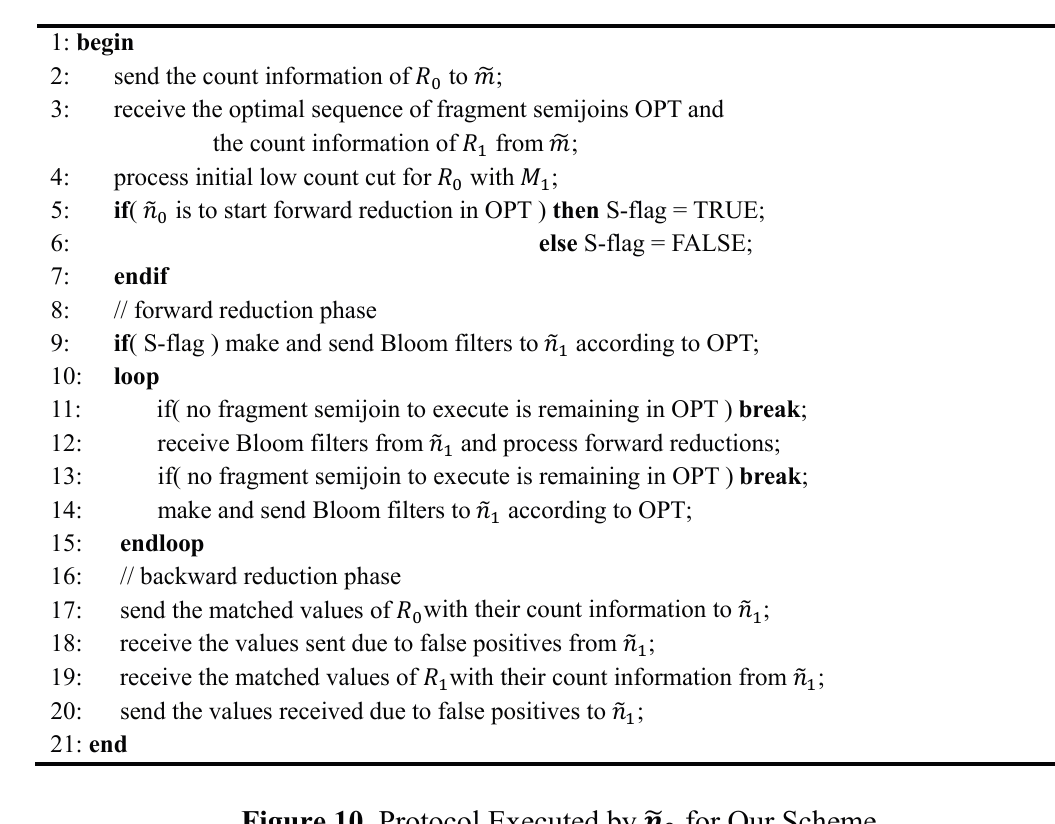
for Our (cid:2777)